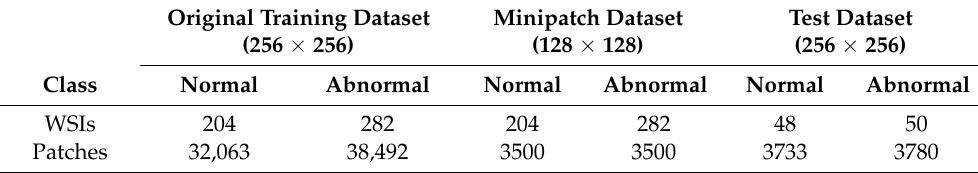
Table 1. Compositions of datasets.